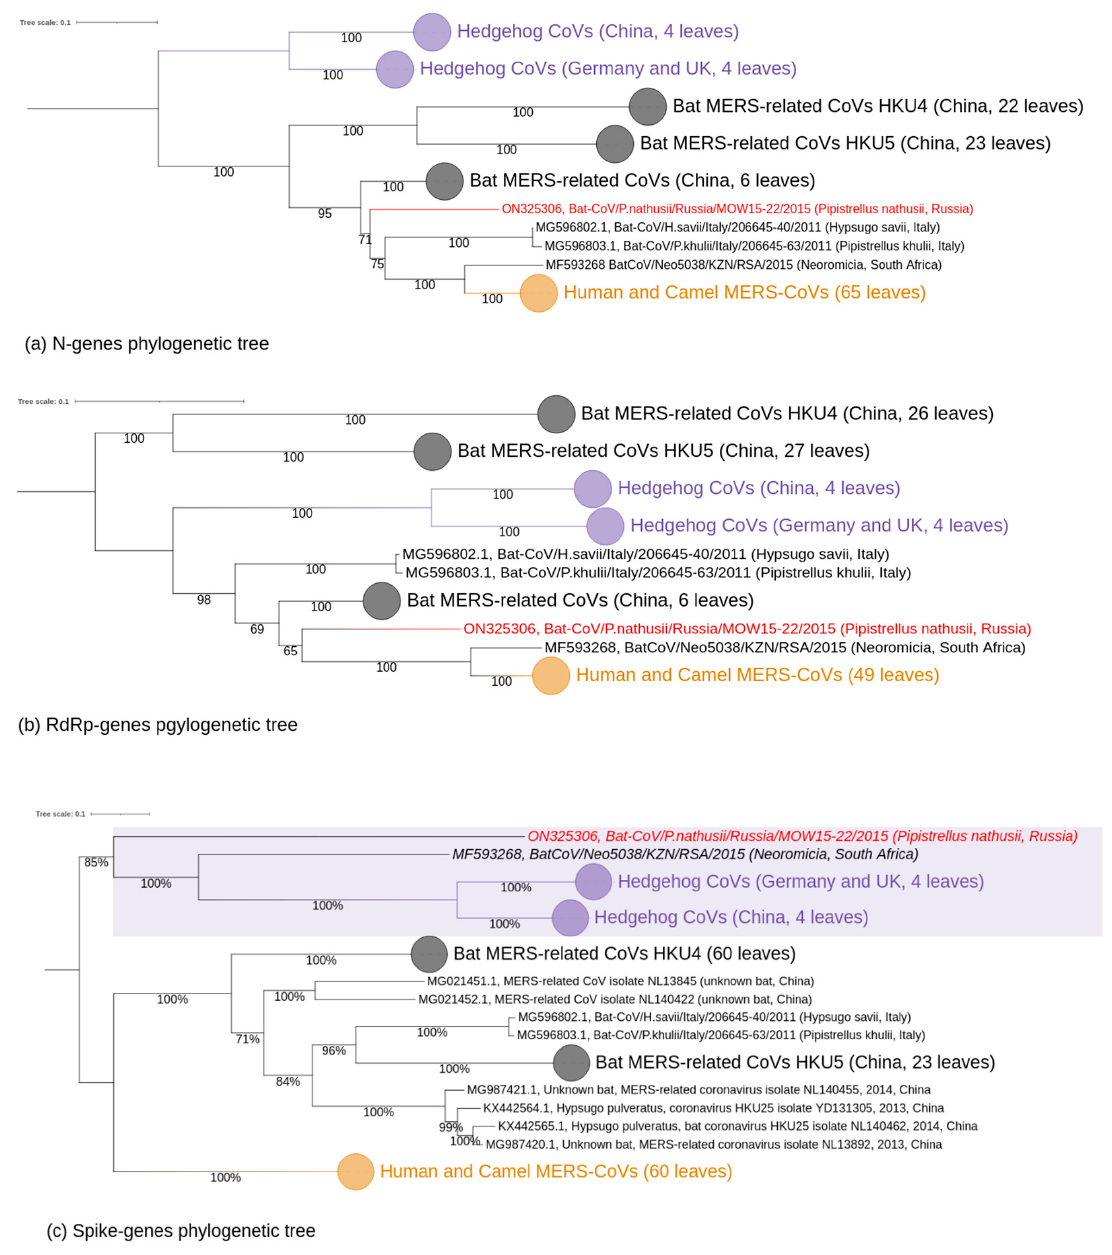
Figure 4. Phylogenetic trees of protein coding regions of Merbecovirus genomes. Numbers show bootstrap values. The virus described in this study is labeled in red. ( a ) tree constructed on 65 partial N-gene sequences (1272–1297 bp). Best-fit model of substitution according to BIC: TIM2 + F + I + G4; ( b ) tree based on 2798–2802 of partial RdRp (NSP12) protein coding regions. Best-fit model of substitution according to BIC: GTR + F + I + G4. ( c ) tree based on the partial spike glycoprotein protein encoding regions. Best-fit model of substitution according to BIC: GTR + F + I + G4. Molecular docking showed that spike-protein of MOW-BatCoV/15-22 and DPP4 of M. brandtii and E. europaeus share binding sites. Thus, 43 binding sites were shown for